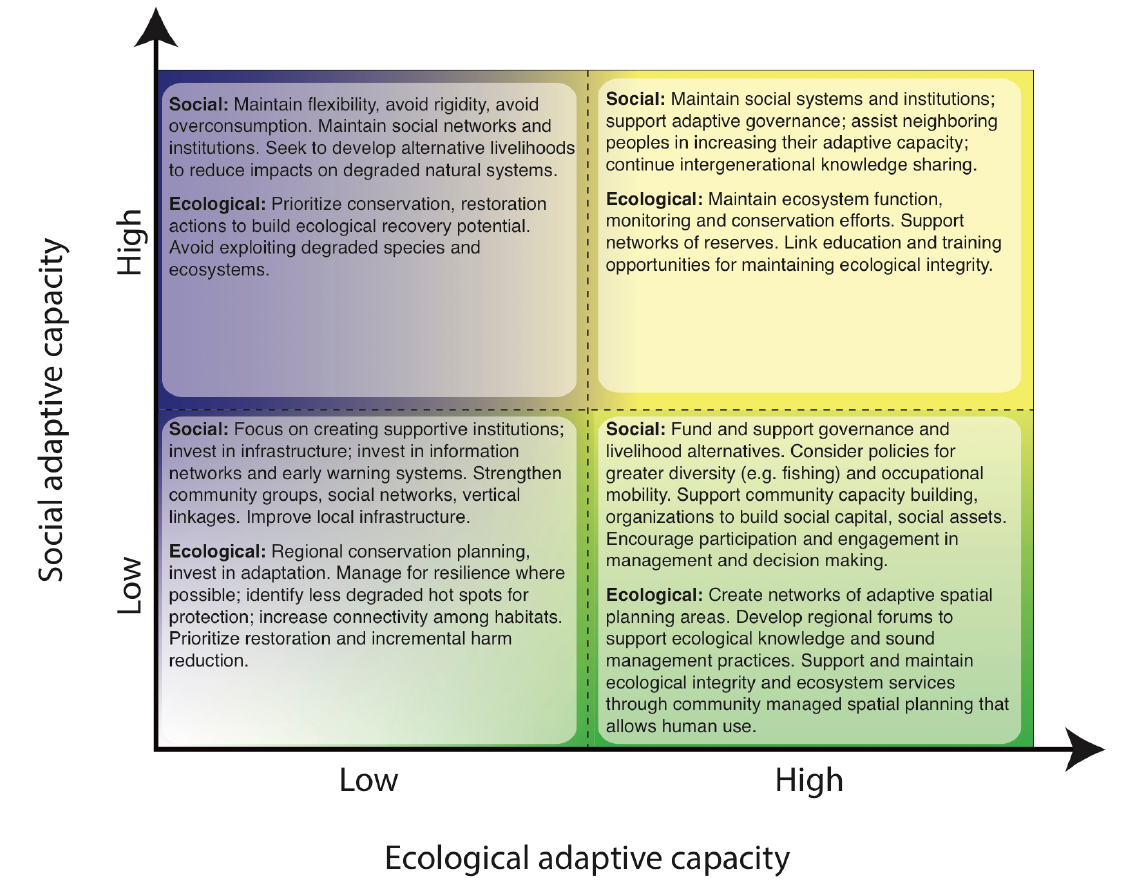
Fig. 3. A conceptual framework to link adaptive capacity assessment to adaptive capacity building in social- ecological systems. The adaptive capacity of the linked social-ecological system is first identified by assessing the level of ecological and social adaptive capacity (i.e., by conducting multiple or integrated assessments). With knowledge of the current state of the system, actions can be taken to build further adaptive capacity (e.g., improve ecological adaptive capacity) to move the system to a more desirable state. If considerations of trade- offs are not included, the system’s adaptive capacity could shift in focus without gains in total adaptive capacity (e.g., ecological adaptive capacity increases at the cost of decreasing social adaptive capacity). The model is based on similar schematics by McClanahan et al. (2008) and Ban et al. (2013); actions build on those suggested by Salafsky et al. (2008) and Cinner et al.